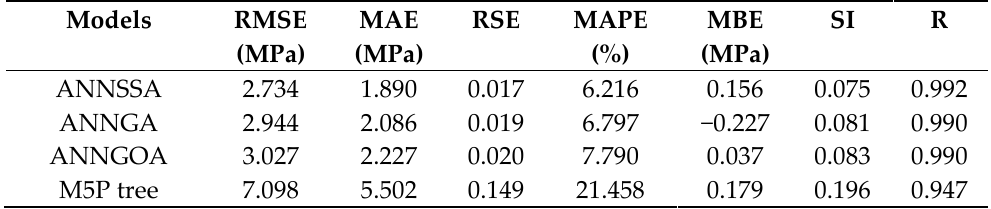
Table 3. Statistic indicator of